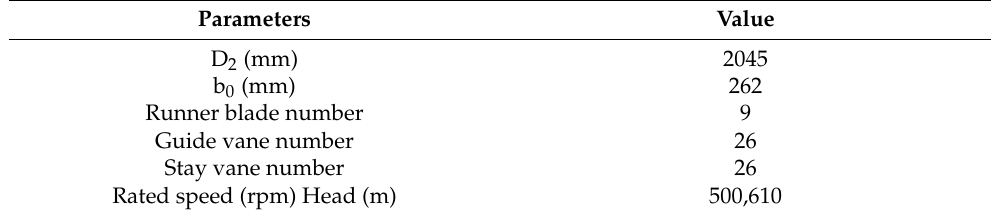
Figure 1. Pump turbine’s ( a ) geometry and ( b ) GV number. Table 1. Parameters of the pump